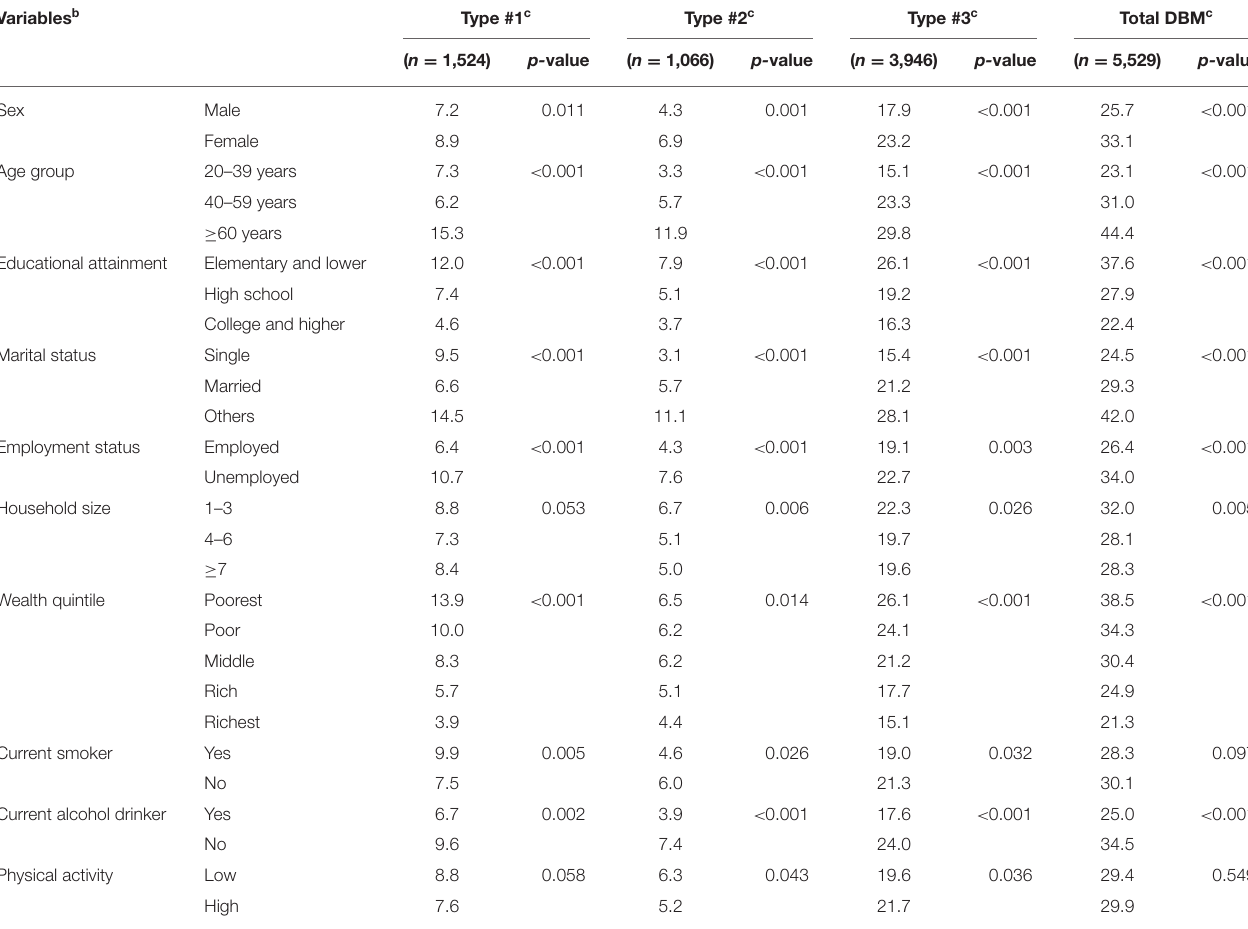
TABLE 3 | Socio-demographic and lifestyle characteristics of adults by double burden of malnutrition characterizations a . Variables